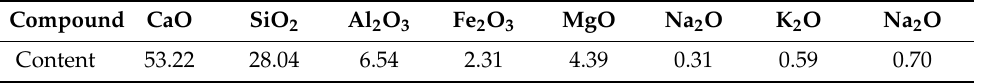
Table 2. Chemical composition and alkali content in CEM II / B-S 42.5 N cement clinker (%).